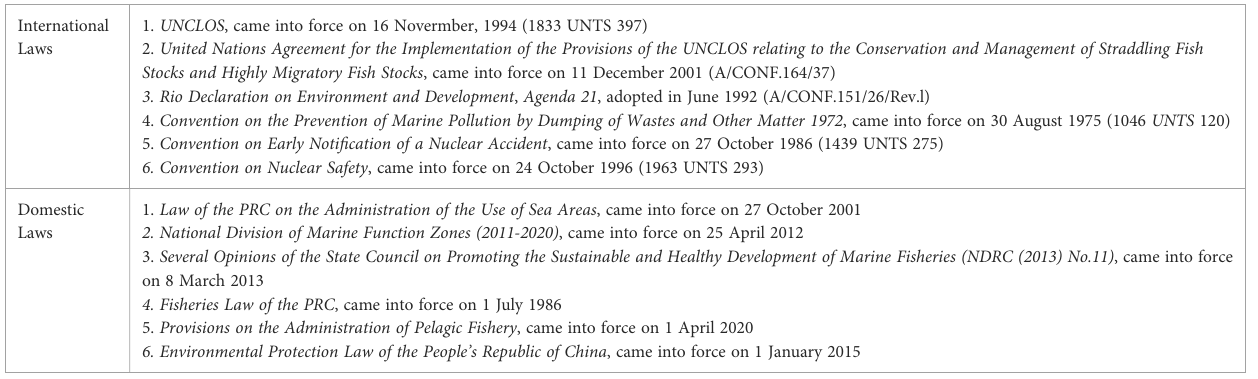
TABLE 1 China ’ s relevant existing fi shery